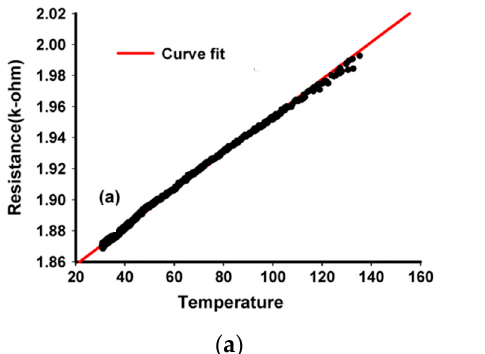
Figure 7. Resistance–temperature curve of a cryogenic sensor based on CNTs vertically grown by CVD method [32], reprinted by permission of the publisher (Taylor & Francis Ltd) 3.2. Characteristics of Temperature Sensors Based on CNTs Thin Films Assembles by Gluing, Printing, Filtration over a Membrane, and Spraying For the integration of CNTs thin films, as sensitive material, into microstructures, in order to obtain temperature sensors, several methods have been employed. In this subsection, we briefly present the characteristics of the following assembling procedures: gluing, printing, filtration over a membrane, and spraying. Recently, MWCNTs have been successfully integrated into flexible electronic devices for temperature measurement [35–38]. Flexible temperature sensors have become attractive to researchers because of their ability to improve the functionality of integrated bio-parameter monitoring systems such as the body temperature control systems of a soldier in the battlefield or of a patient. Karimov [37,38] obtained flexible temperature sensor by deposition of MWCNTs powder between adhesive elastic polymer tape [37] and on paper substrate [38]. To better adhere the film to the paper substrate, a pressing procedure was applied. The sensors terminals were connected to the sensitive film by silver paste and tested at temperature range 20–70 °C, presenting semiconductor behavior with a maximum TCR of − 1.26 %/°C for the MWCNTs film on the elastic polymer tape